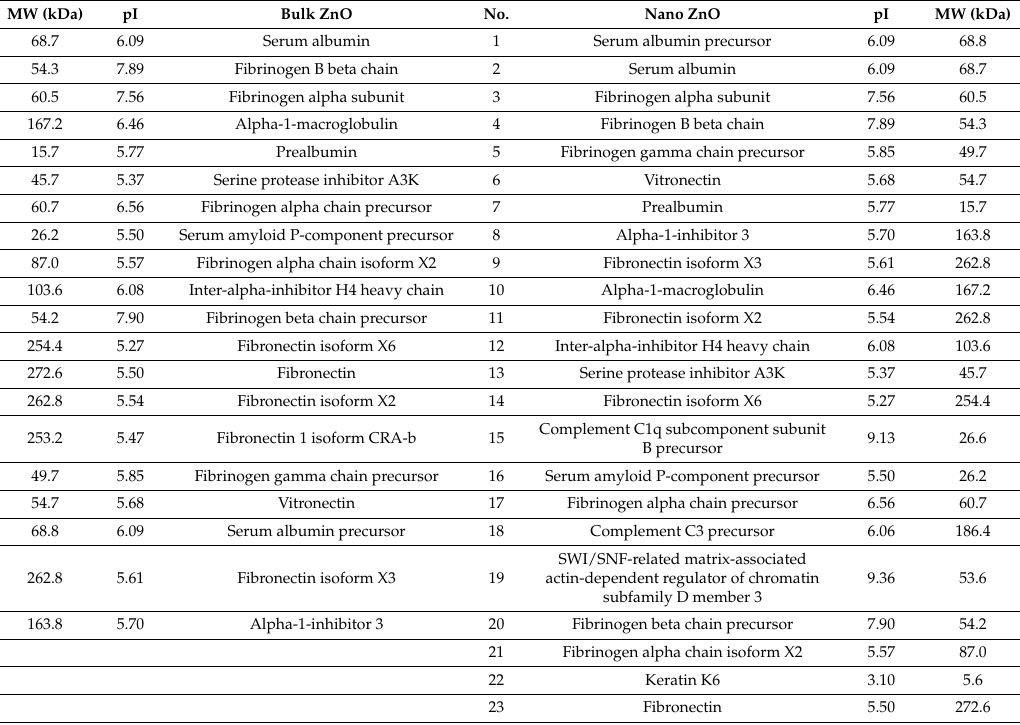
Table 3. List of the most abundant plasma proteins adsorbed on bulk and nano ZnOs as determined